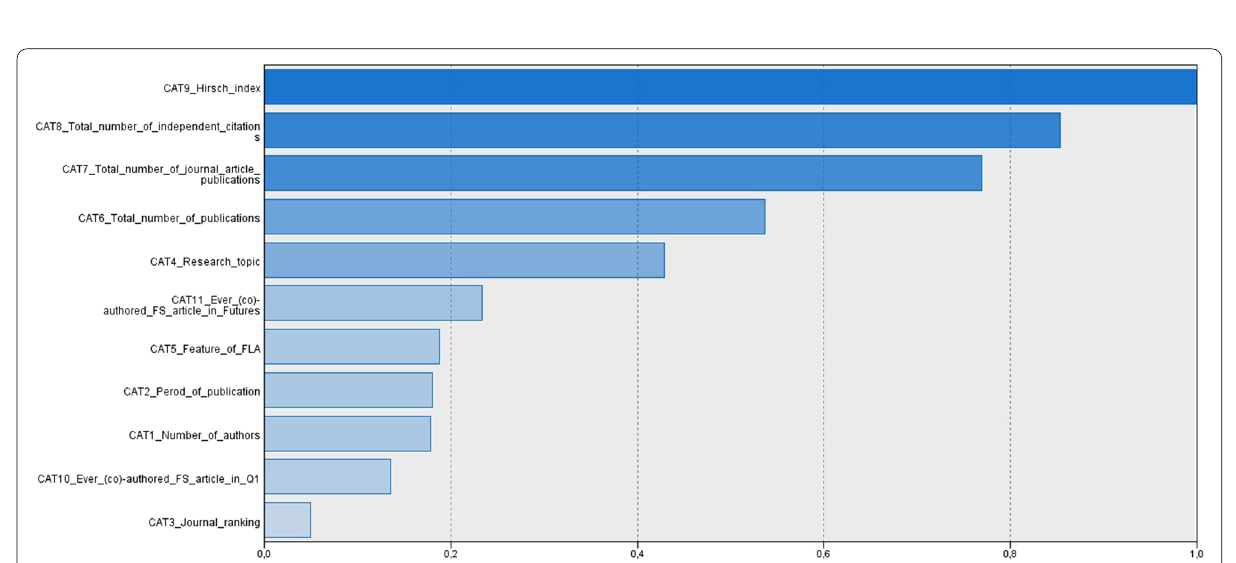
Fig. 4 Importance of clustering variables in the SOM